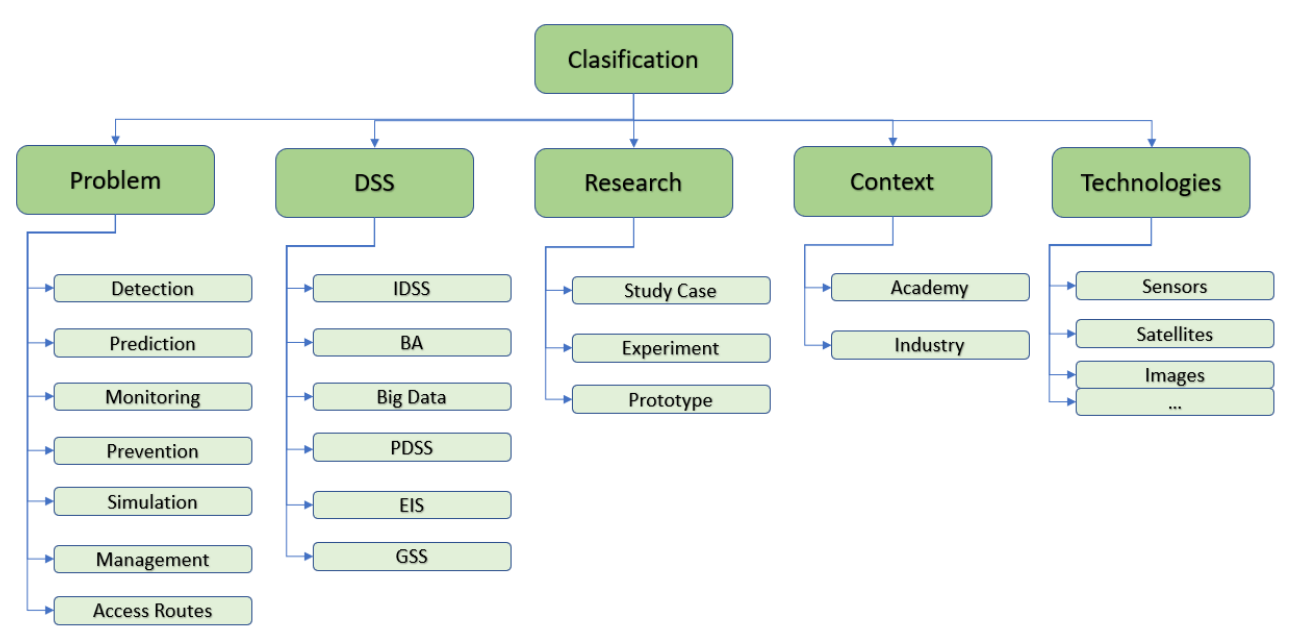
Figure 4. Classification scheme.